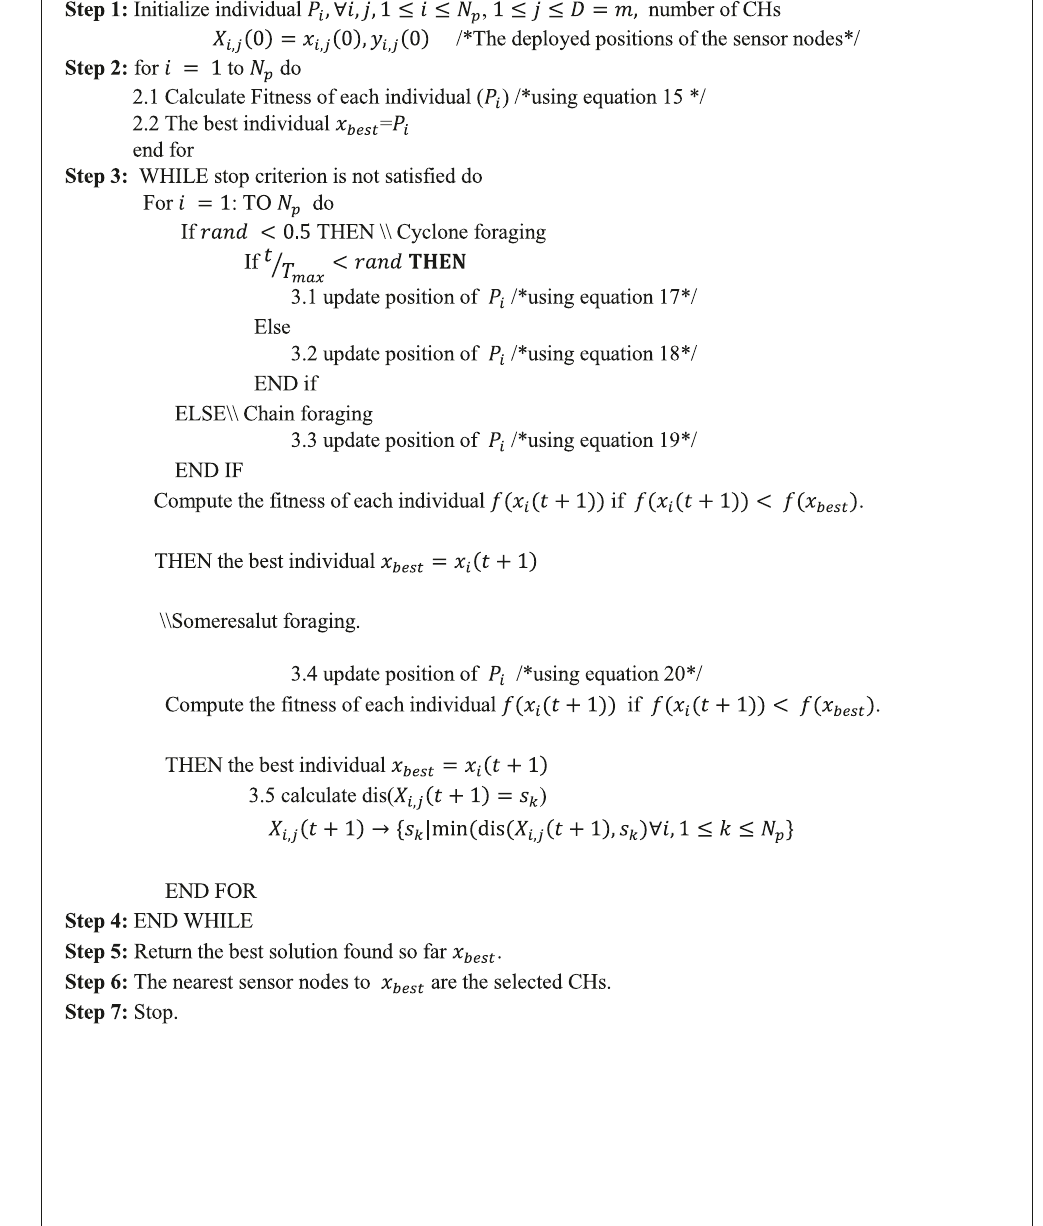
Figure 1: Pseudocode of the proposed MRFO-based CH selection